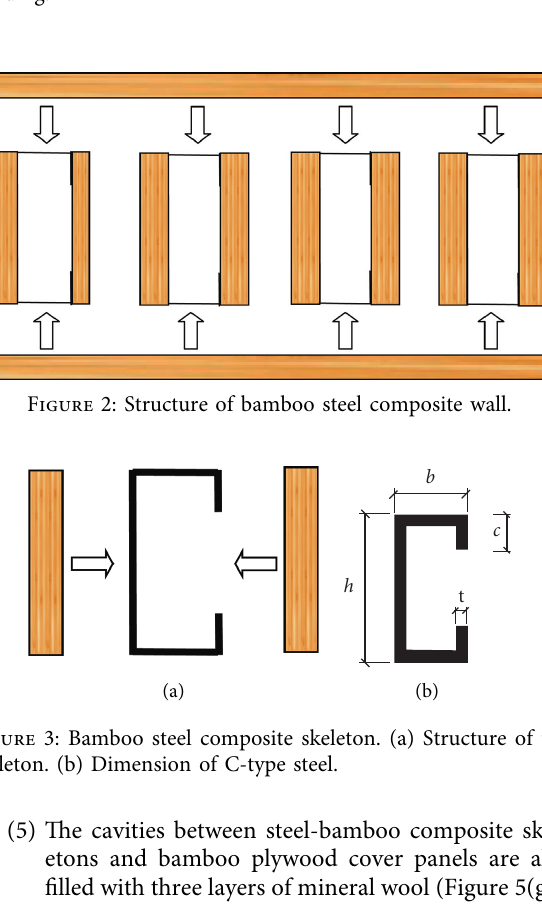
Figure 1: Testing building. (a) Front view. (b) Lateral view. (c) Installation of polystyrene board. (d) Simulation model. (e) Plan view of building.